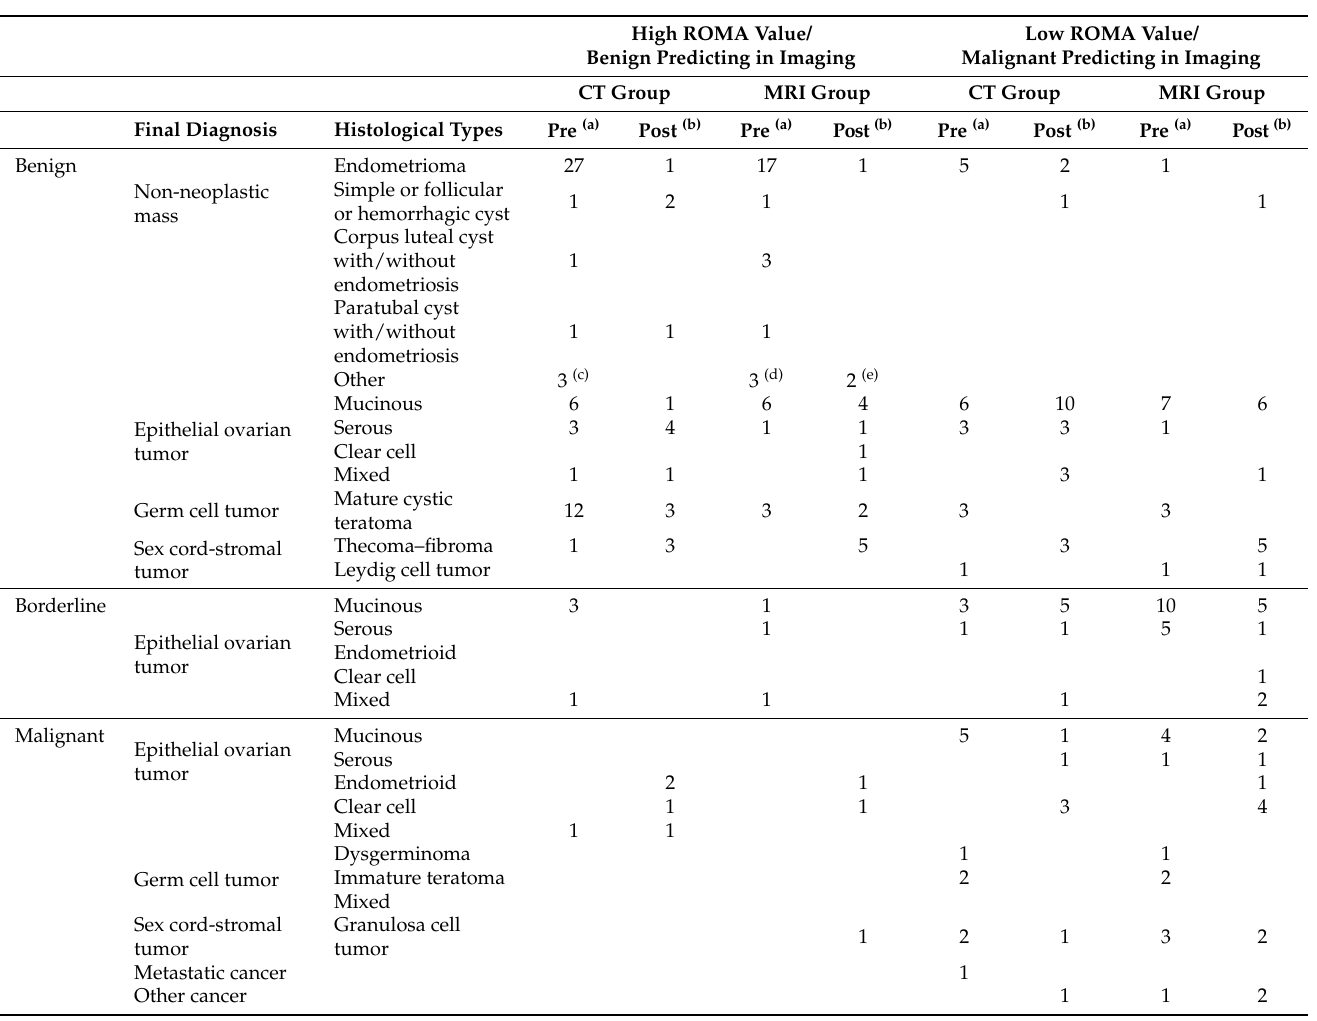
Table 3. Final diagnosis of cases with prediction discrepancy between ROMA and imaging. High ROMA Value/ Benign Predicting in